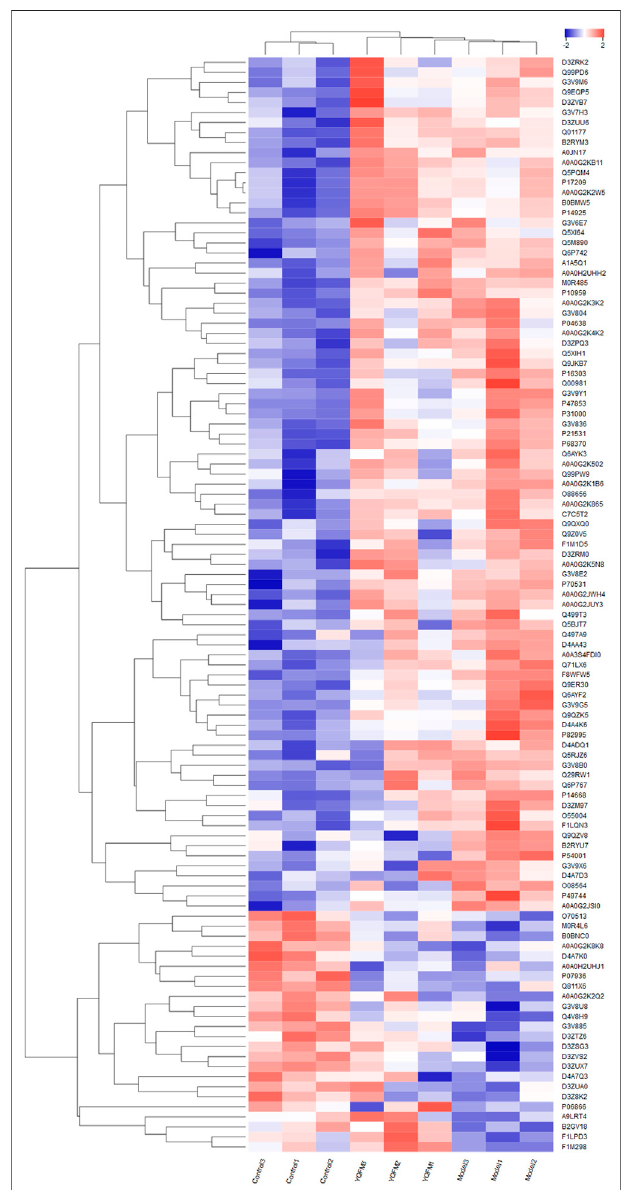
FIGURE 7 | Cluster analysis of differentially expressed proteins among the three groups. Color changes with protein expression, blue indicates negative correlation, red indicates positive correlation, the stronger the color, the strongest